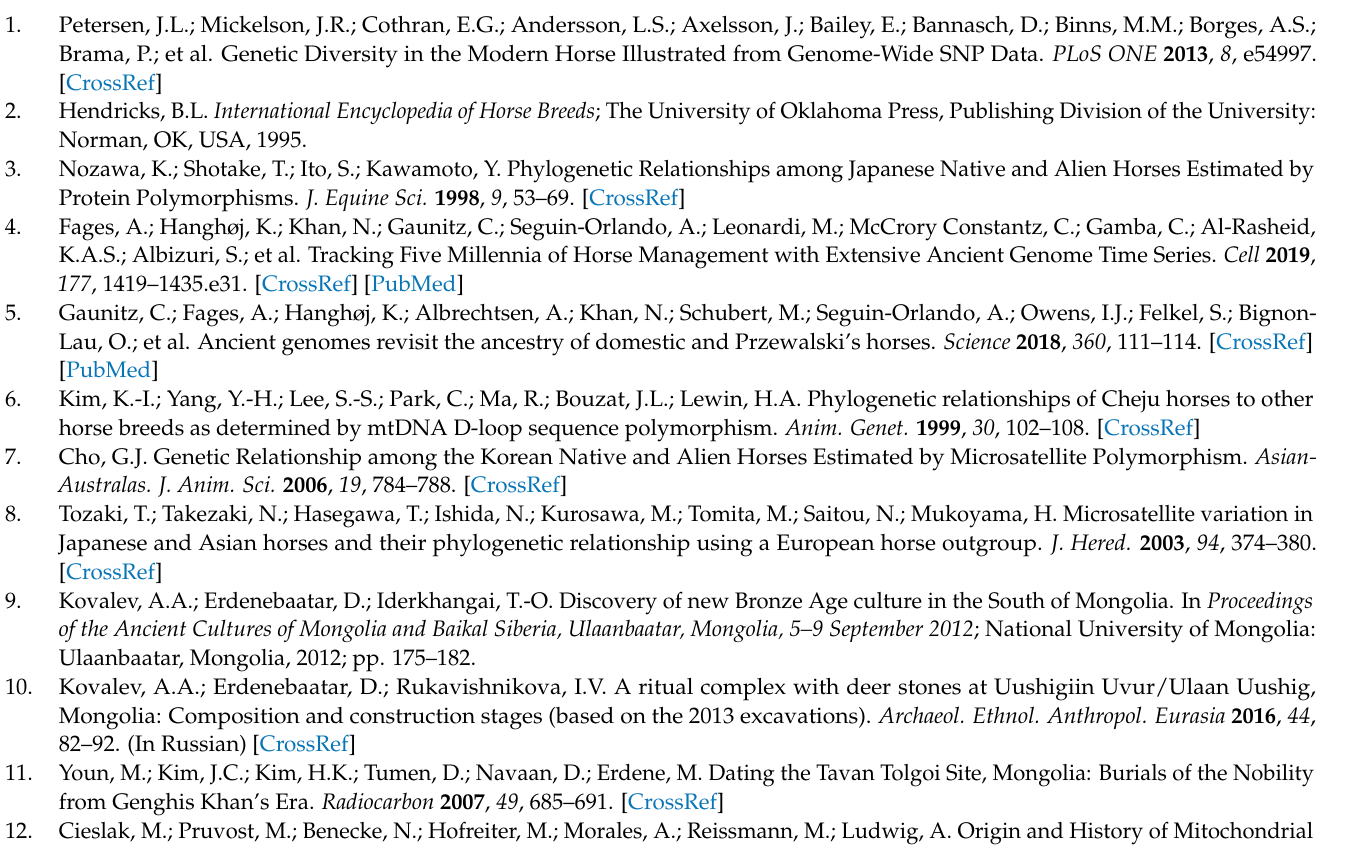
Table S1: Information about bone specimens of the studied ancient horses, Table S2: Information about the mitogenome sequences from